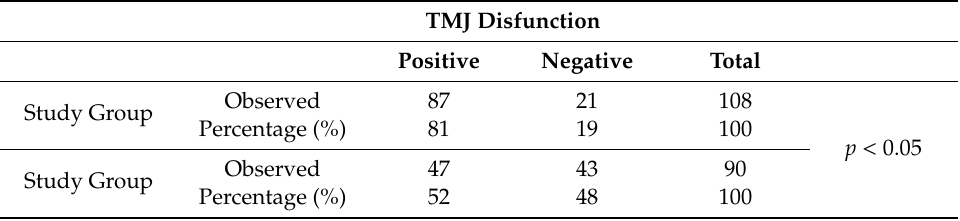
Table 1. Data distribution from the anamnestic form (Helkimo’s index). Significance set at p < 0.05 according to the Chi-Square test.